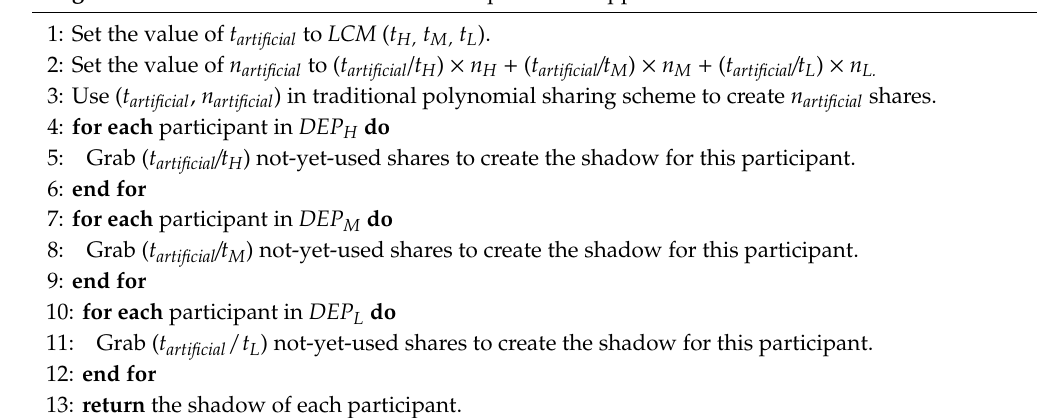
Algorithm 1. To create shadows for cross-department